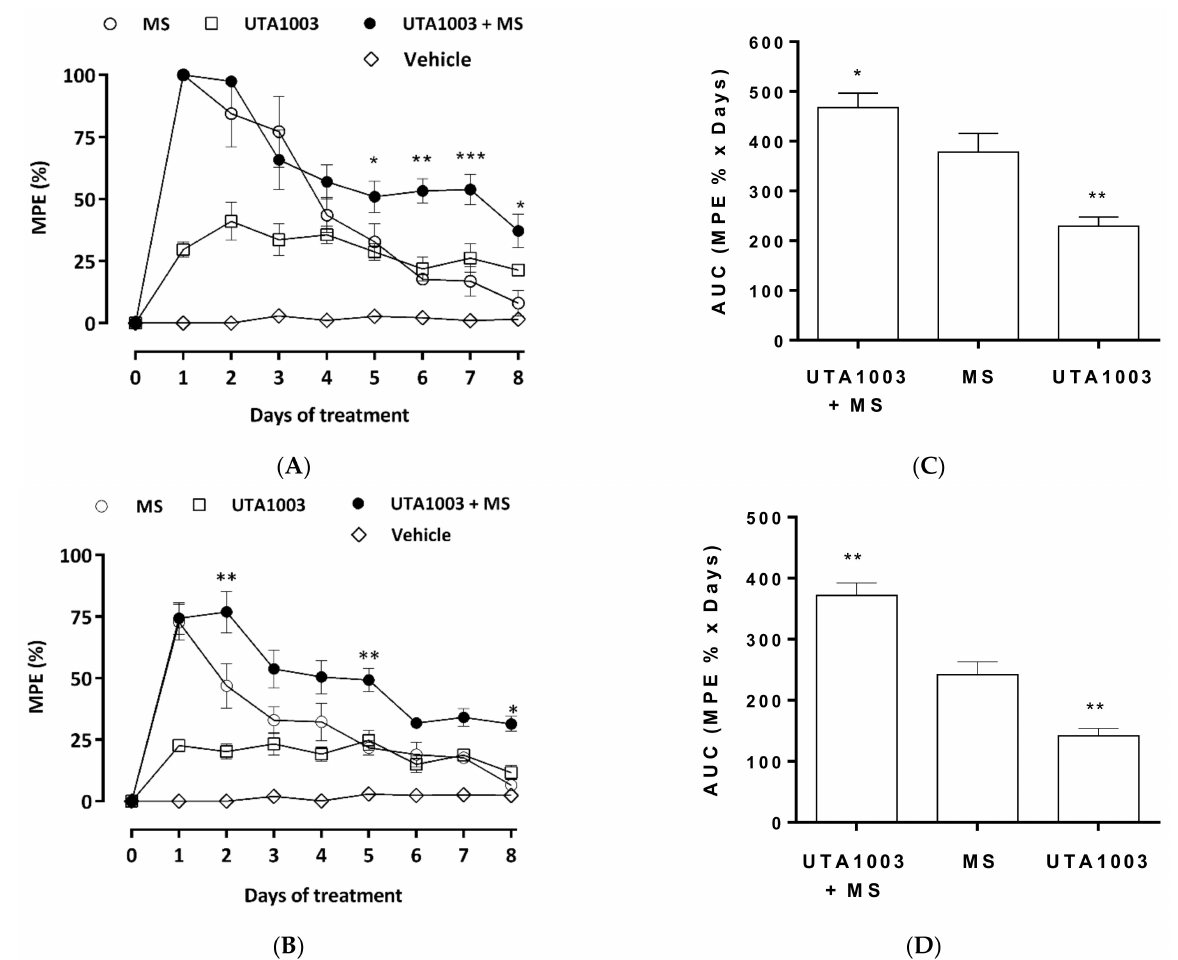
Figure 5. Antinociceptive effects of chronic administration of opioids. Antinociceptive effects after twice-daily subcutaneous treatment with vehicle, UTA1003 (24.6 mg/kg), morphine (MS, 3 mg/kg), or their combination were measured in Sprague Dawley rats. Antinociception was measured daily at 30 min post injections over a period of 8 days using tail flick ( A ) and hot plate ( B ) assays. Statistically significant differences in antinociception at the same time point were calculated between MS and MS + UTA1003-treated animals. Total antinociception was calculated using area under the curve analysis (AUC) for the tail flick ( C ) and hot plate ( D ) assays. Statistically significant differences in total antinociception were calculated for each group against MS-treated animals. Significance was calculated using one-way ANOVA with Bonferroni’s multiple comparisons and shown as * p < 0.05, ** p < 0.005, *** p < 0.0001. Values are presented as mean ± SEM (n = 6 animals per